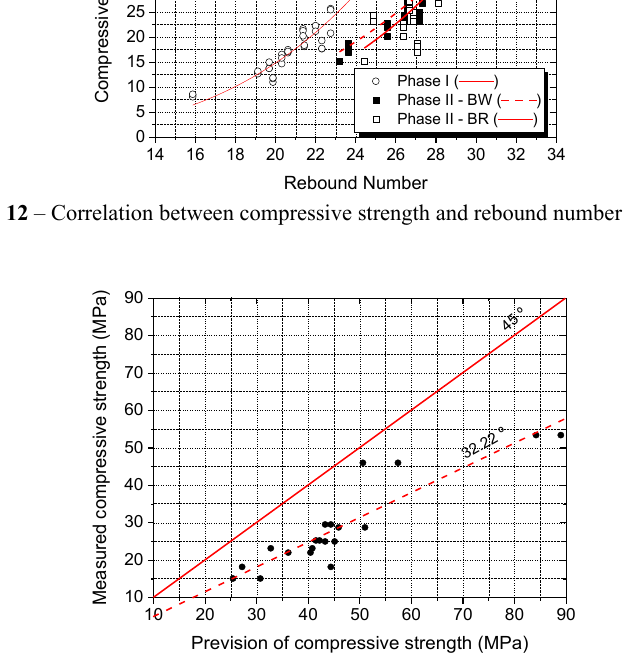
Figure 13 – Relation between prevision and measurement of compressive strength of the concrete used in hollow-core